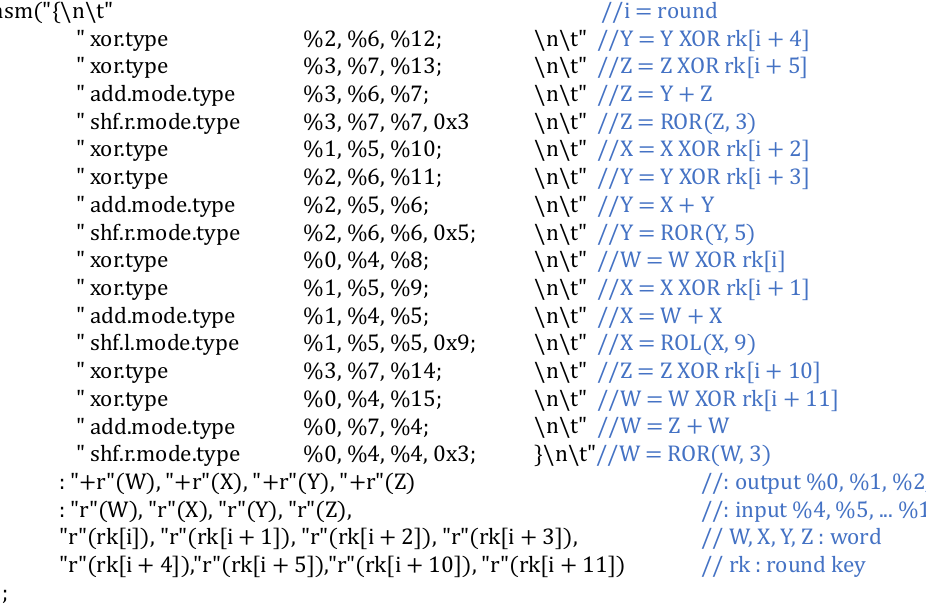
Figure 14. Example of inline PTX assembly codes of LEA round